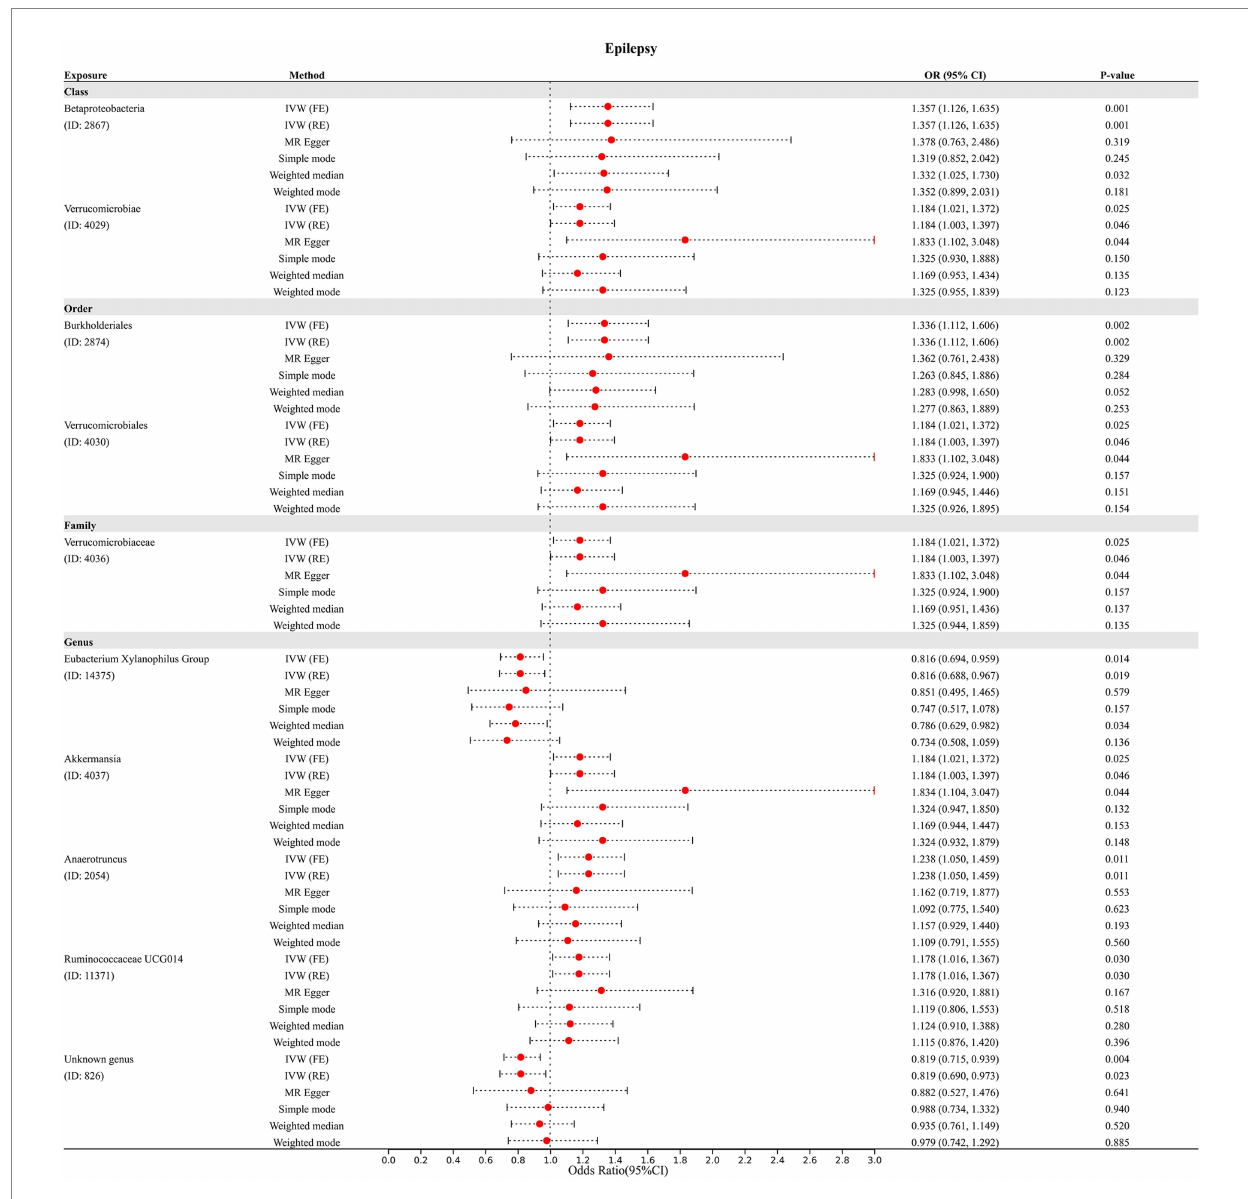
FIGURE 3 Diverse Mendelian randomization (MR) results for 10 GM taxa causally associated with